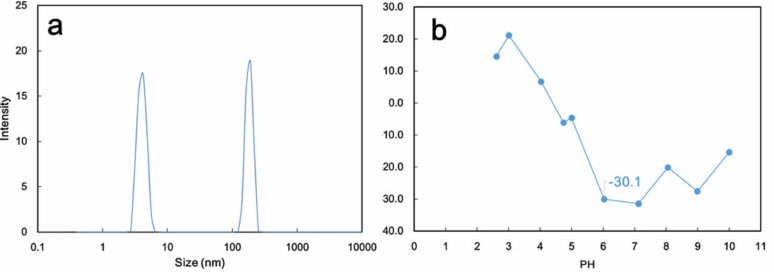
Figure 8. ( a ) Size distribution of BSA in water solution and ( b ) zeta potential of BSA in aqueous solutions at various pH levels, which were adjusted with ammonia or hydrochloric acid